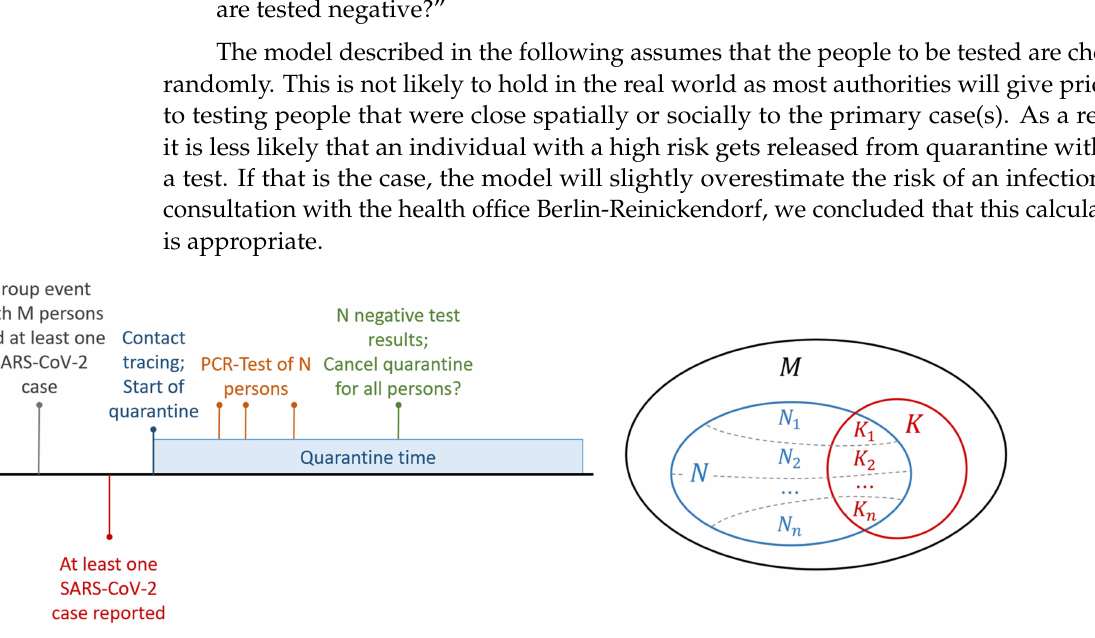
Figure 1. Left : Timeline of the events starting from the group event until the quarantine decision. Right : Overview of the group with M , the possible number of infected K , and the negative tested persons N . For N and K , the contact persons are divided into subgroups N d and K d , which are tested on day D d , d ∈ { 1, . . . , n } , are also